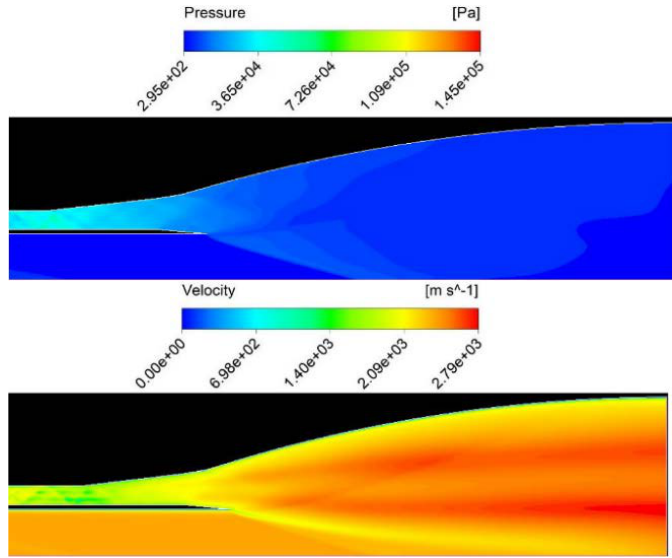
Figure 21. Pressure and velocity contours for SERN DP456.